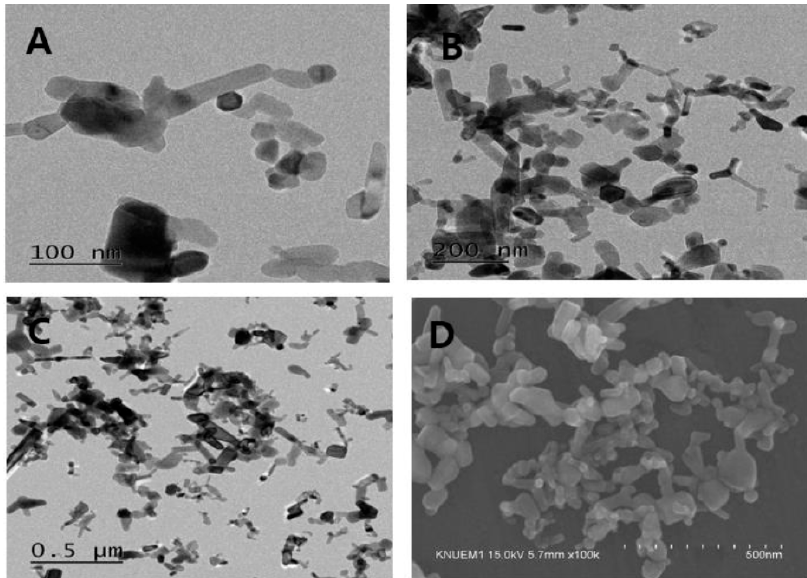
Figure 1. TEM ( A – C ) and scanning electron microscopy ( D ) images of zinc oxide nanoparticles (ZnO NPs). ZnO NPs exhibited an agglomerated and rod-shape morphology.